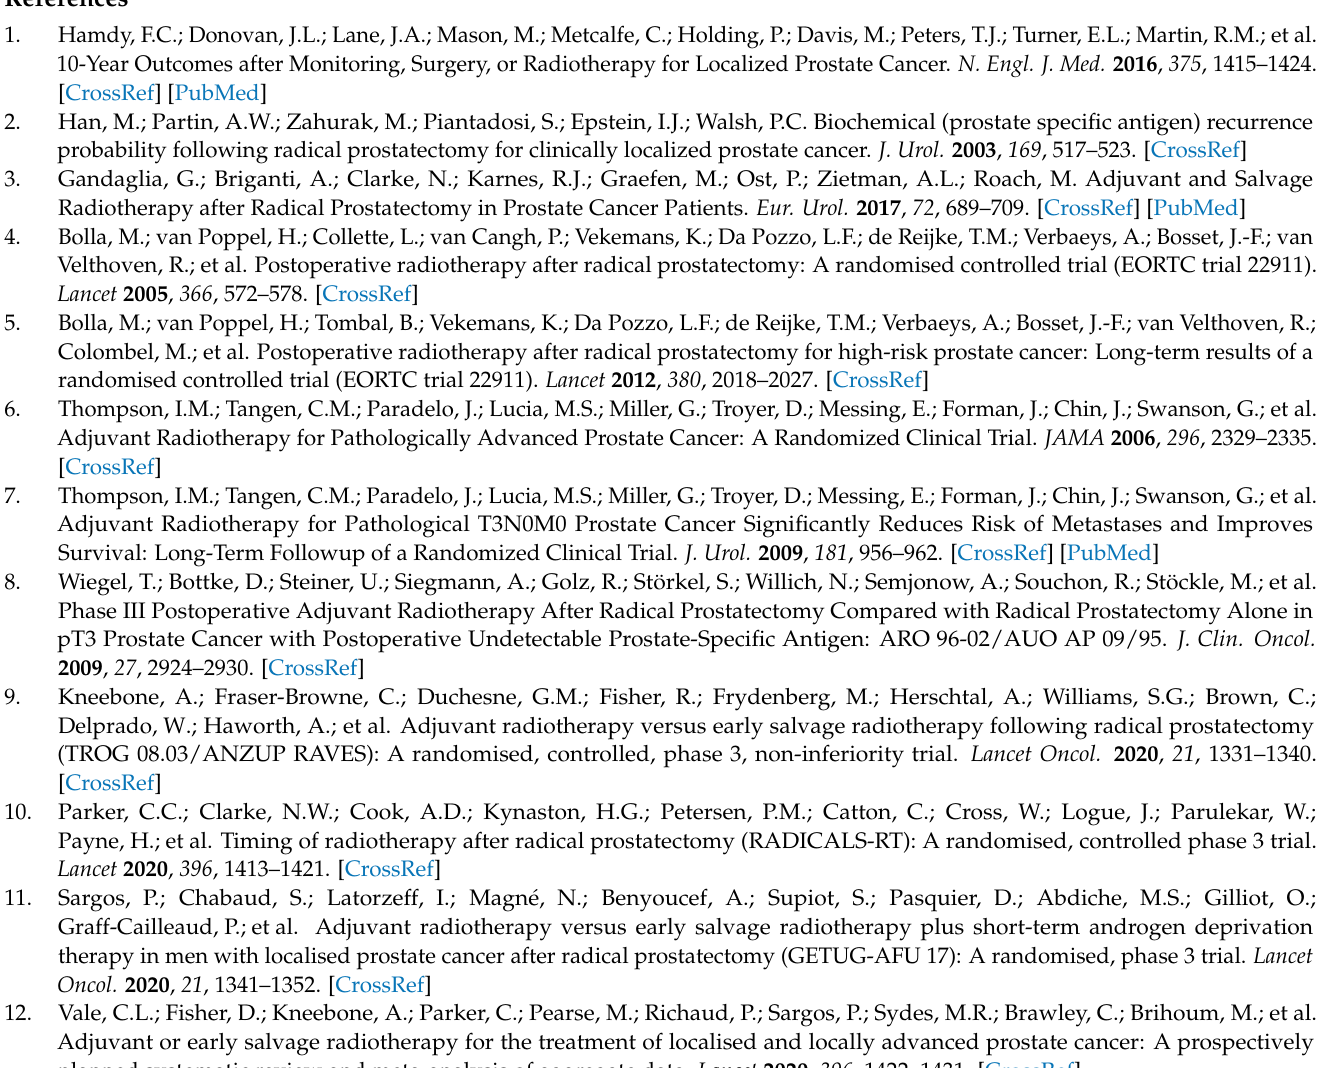
Table S2: Target volume delineation and use of markers for tracking; Table S3: Dose constraints used in the individual studies; Table S4: Outlook on currently recruiting